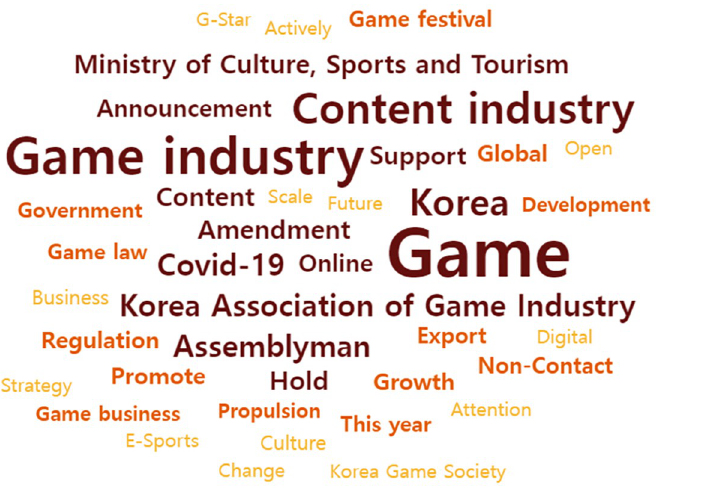
Fig 8. Word cloud of the top 40 keywords in